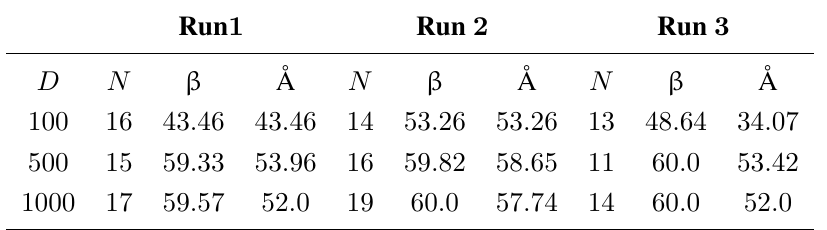
Figure 19. Heat map generated by AMA with 2 cm obstacle length. Table 1. The obstacle length (in pixels) in the best proposed bill β and the agreed bill Å in 3 AMA runs at D nodes density. N the number of proposed bills in each run.